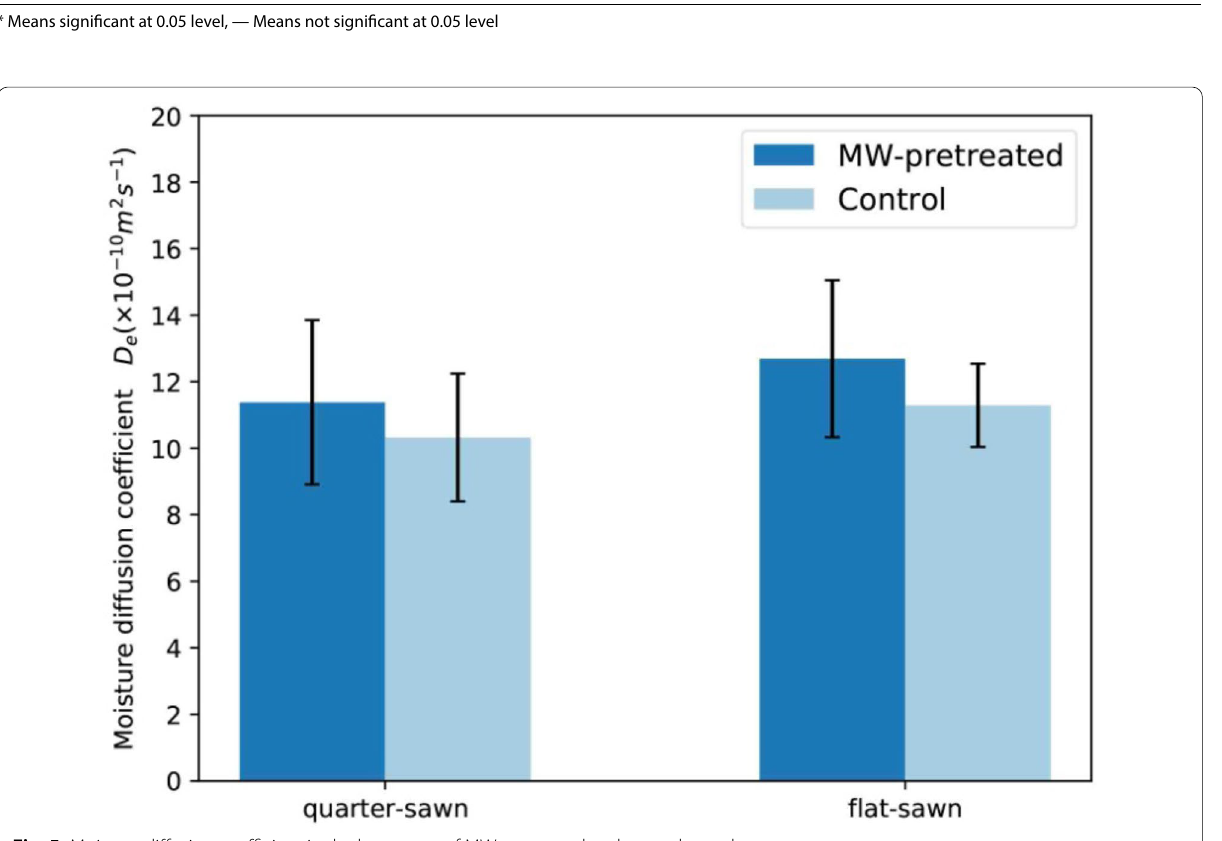
Fig. 5 Moisture diffusion coefficient in the later stage of MW-pretreated and control